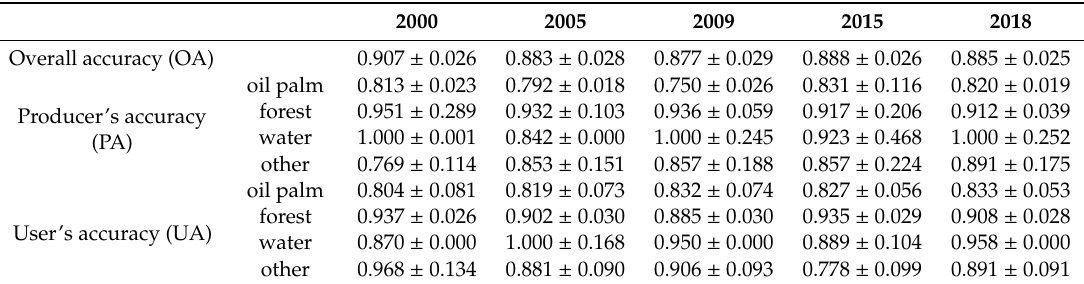
Table 3. The accuracy of the classification results during 2000–2018 (95% confidence intervals).